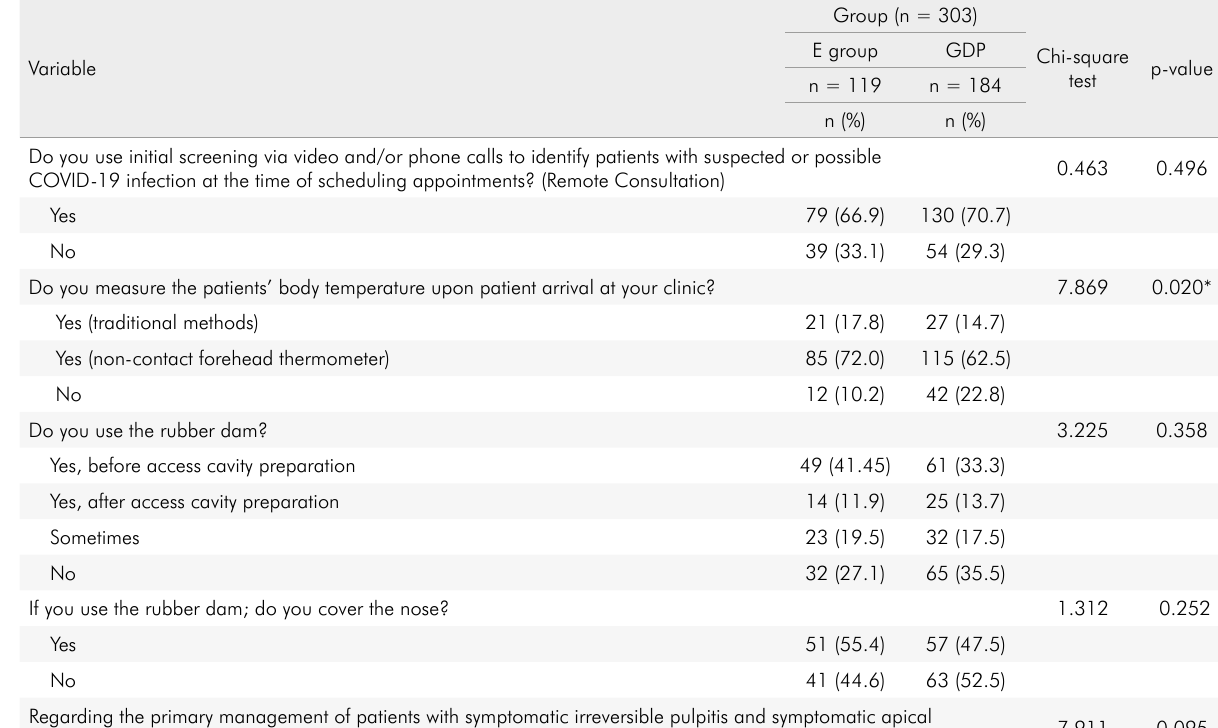
Table 2. Questionnaire questions, given answers, and their percentages by endodontists (E) and general dental practitioners (GDP). Variable